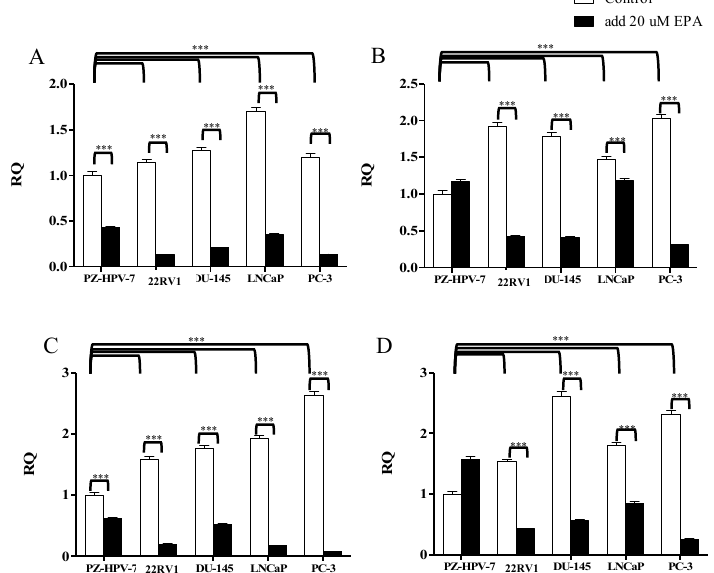
Figure 3. Comparison of the relative expression of KLK gene expression in each cell before and after treatment with EPA, measured by qRT-PCR. White bars represent original cells and black bars represent cells after treatment with 20 µ M of EPA. Y -axis risk quotient (RQ) = tumor cells/reference sample. The PZ-HPV-7 cell was used as a reference sample, and its number quality was normalized to 1, then further compared with other cells. All the cells were also compared to their original cells. ( A ) KLK2 gene expression, ( B ) KLK4 gene expression, ( C ) KLK6 gene expression, and ( D ) KLK14 gene expression. The data presented in the figure are the mean ± standard deviation. *** represents p <